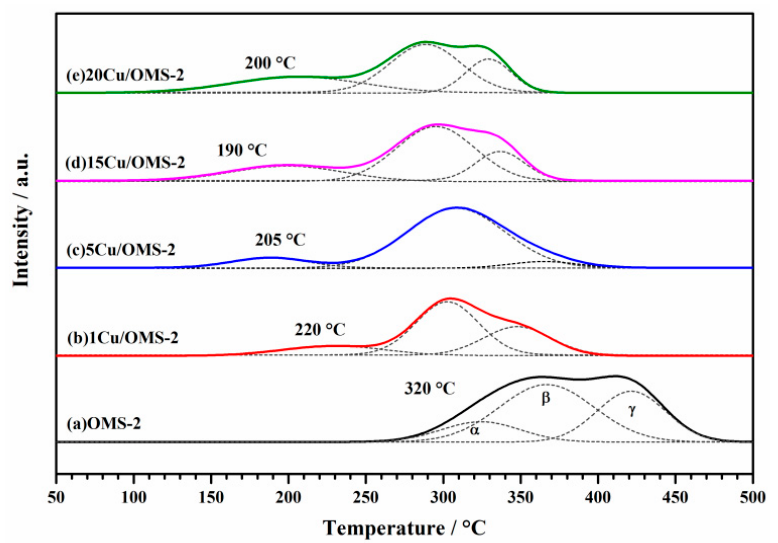
Figure 7. H 2 -TPR profiles of of ( a ) OMS-2, ( b ) 1Cu/OMS-2, ( c ) 5Cu/OMS-2, ( d ) 15Cu/OMS-2, and ( e ) 20Cu/OMS-2.